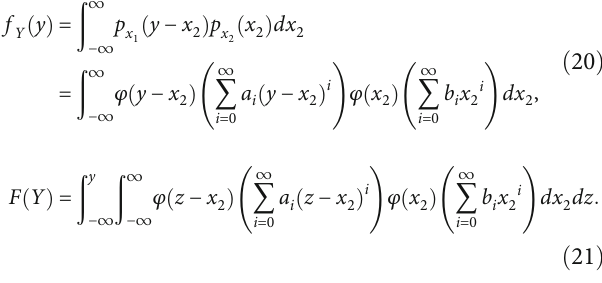
path travel time.